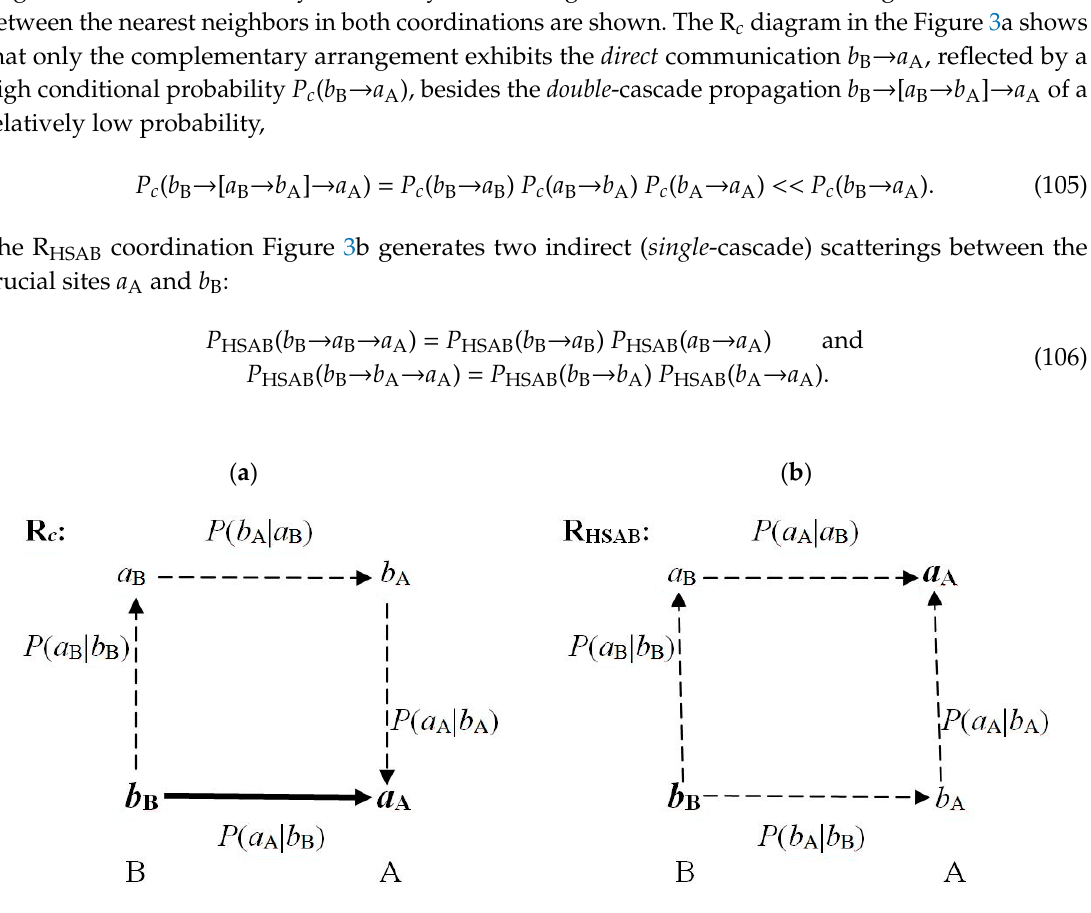
Figure 3. The dominating (nearest neighbor) communications between the chemically bonded sites of the Acid–Base complexes R c ( a ) and R HSAB ( b ), respectively. The former involves a strong (direct) b B → a A propagation between the key sites a A and b B , which determine the overall chemical behavior of reactants, and a weak (intermediate) double -bridge communication b B → [ a B → b A ] → a A , while the latter exhibits only two indirect ( single -bridge) communications: b B → a B → a A and b B → b A → a A